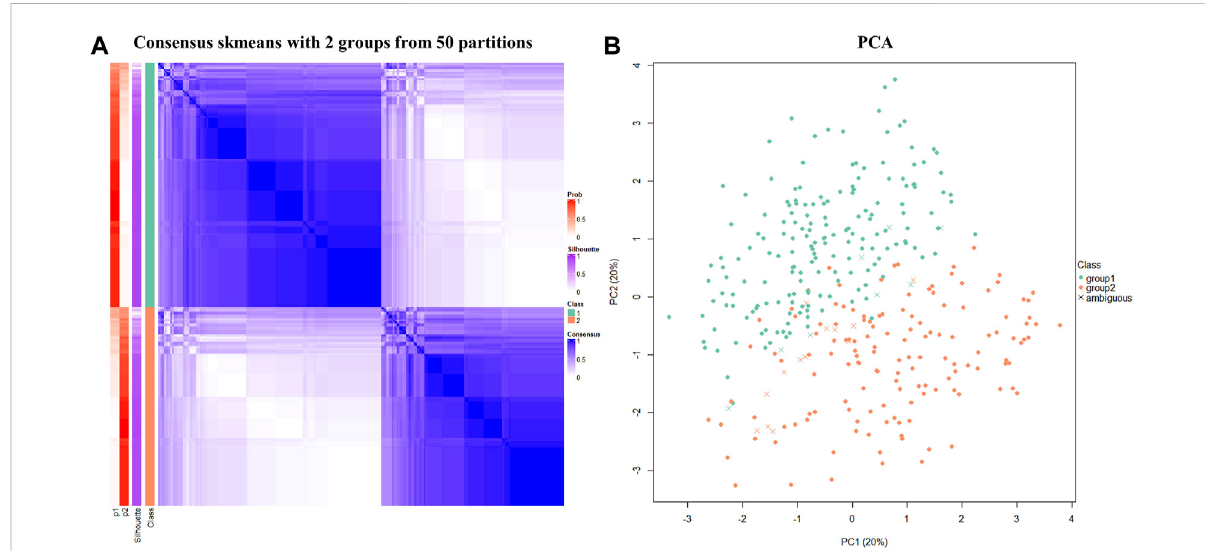
FIGURE 2 The consensus clustering analysis identi fi ed two subgroups within psychiatric patients. (A) The consensus matrix heatmap plot visualized the stabilityofthetwosubtypes.The “ p1 ” and “ p2 ” labelsrefertotheprobabilityofthesamplebeingclassi fi edinto “ class1 ” and “ class2, ” respectively,after clustering was repeated 50 times. “ Prob ” refers to the calculated probability of the sample being classi fi ed into the corresponding subgroup. The “ consensus ” legend refers to how consistent two samples were in the same subgroup. (B) The PCA plot con fi rmed that there were two subgroups of psychiatric patients. The con fi dent samples (silhouette score > 0.5) are classi fi ed into two subgroups obviously separated from each other, and the ambiguous samples (silhouette score < 0.5) are indicated by crosses on the plot.